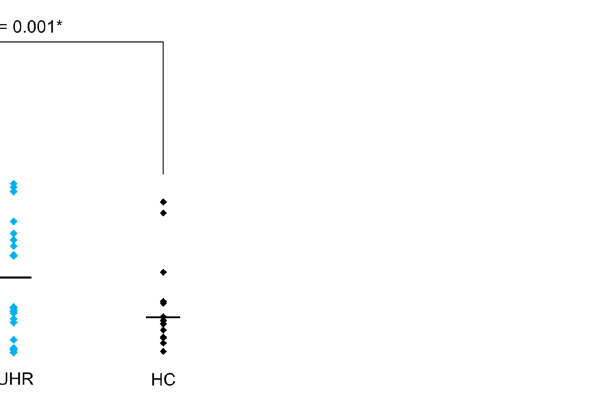
Figure 2. The plasma levels of glutamate in first-episode psychosis (FEP), ultra-high risk (UHR), and healthy controls